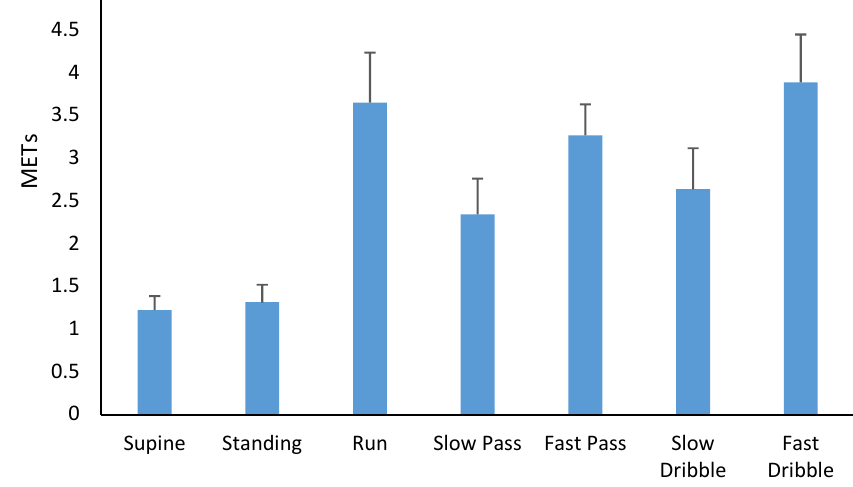
Figure 1. The mean ± SD of METs across each activity.